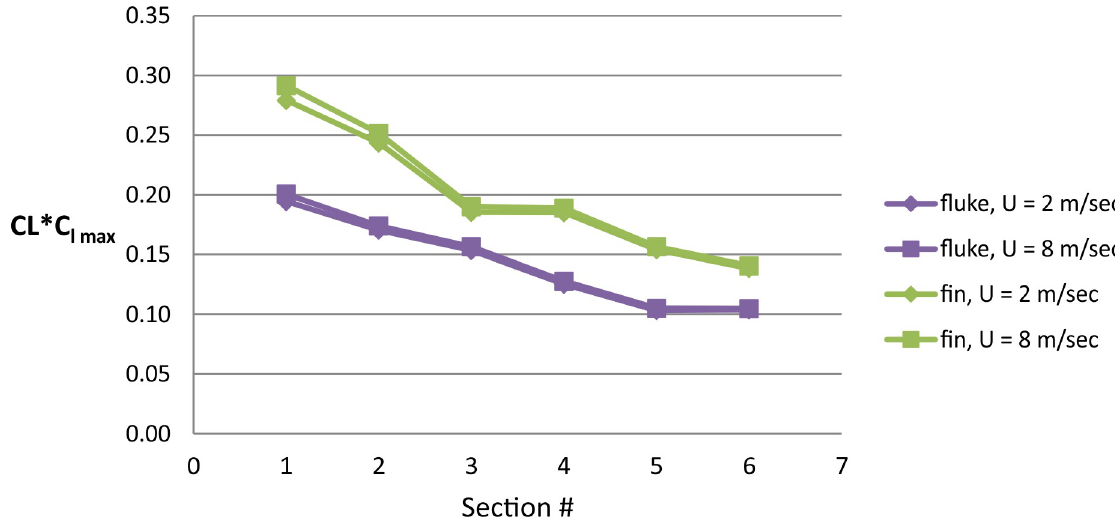
Fig 20. Span-wise lift distribution. Calculated for the cross-sections of the fluke (blue) and dorsal fin (green) of the D . delphis at simulated swimming speed 2 and 8 m/sec.